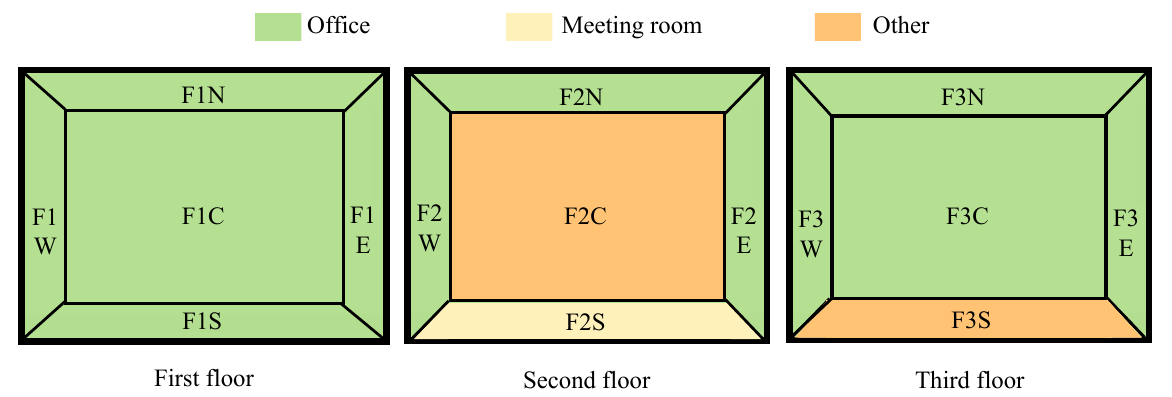
Figure 3. The redefinition of the room type of each thermal zone. Table 3. The definition of the random movement event and status transition event. Table 2. The redefinition of the room type and movement behavior.